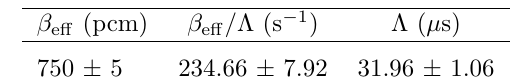
Table 1. IPEN/MB-01 benchmark model kinetics param- eters